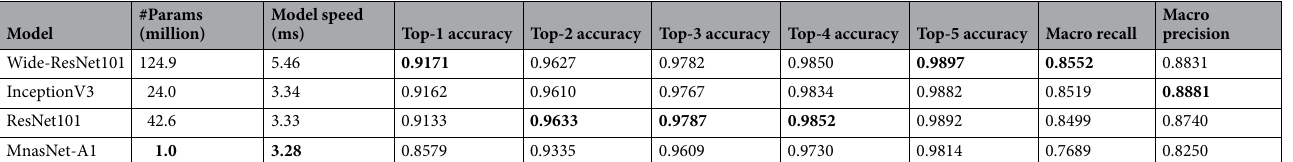
Table 1. Comparison of model size, speed, and performance, ordered by top-1 accuracy. Text in bold indicates the best value in each category. Wide-ResNet101 has the highest top-1 accuracy and macro precision but was substantially slower than the other models. MnasNet-A1 was the fastest model but had relatively poor performance. InceptionV3 was relatively fast while maintaining good model performance with the highest precision and second highest accuracy and recall.